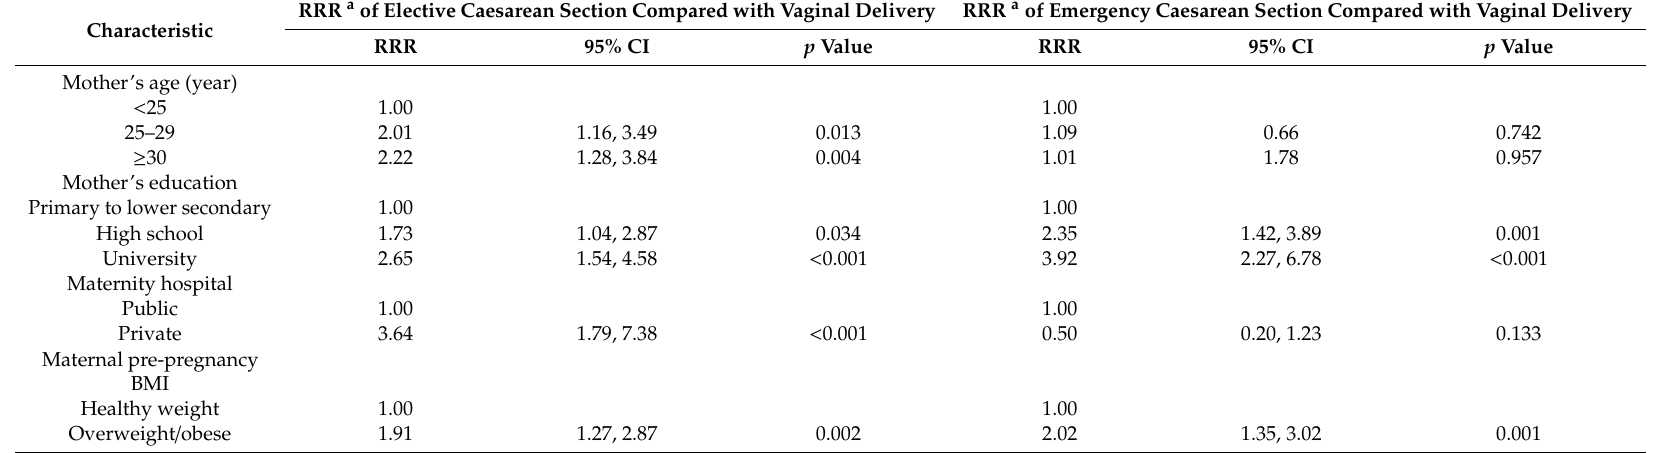
Table 3. Maternal characteristics associated with Caesarean (elective or emergency)